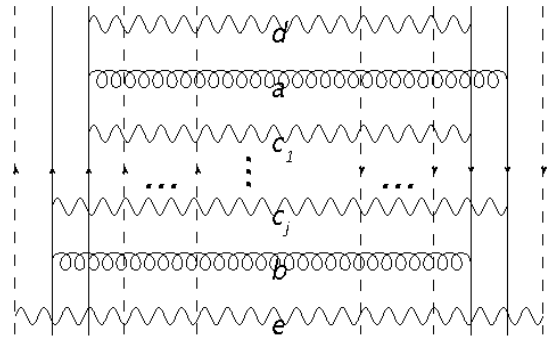
Figure 3 . One speci(cid:12)c contribution to the second term of the emission cross sec- tion (3.6) in which two o(cid:11)-diagonal gluons (curly lines) are supplemented by some diag- onal gluons (zagged